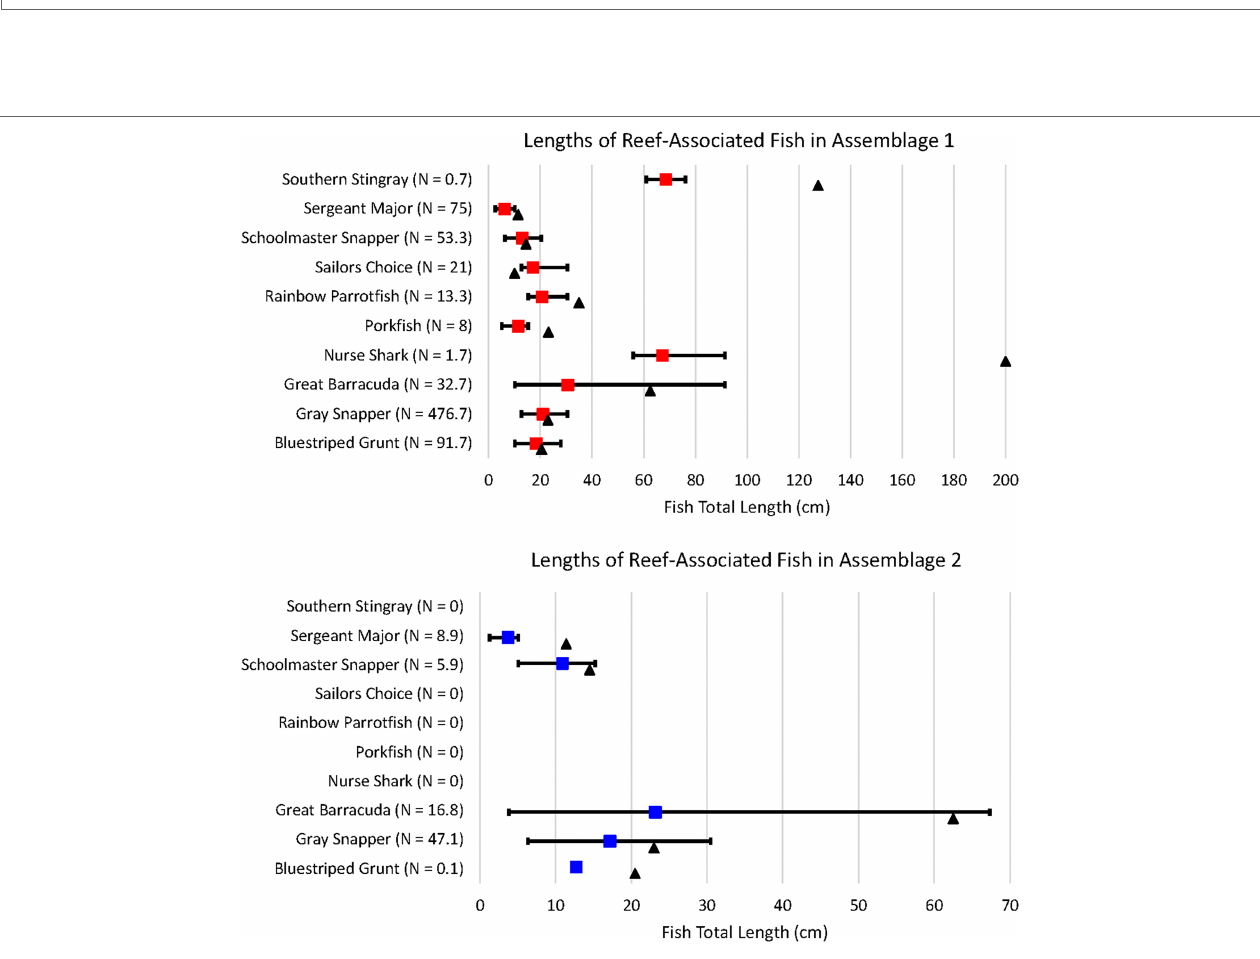
FIGURE 9 | Nine of the ten reef-associated species were present as juveniles; sailors choice were only observed as adults. N denotes the mean number of individuals recorded per site. The colored squares denote the mean length, while the black triangle represents the length at maturity. A table showing the minimum, maximum, and average total lengths of fish in each assemblage, as well as the length at maturity for each species can be found in Supplementary Table 4